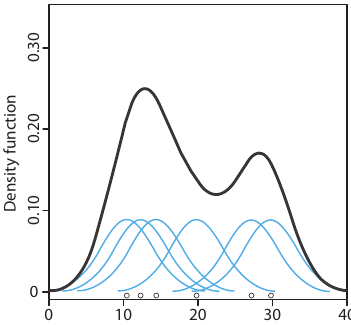
Figure 4. The Gaussian kernel density estimator is a function that stacks a Gaussian “bell curve” on top of each measurement and whose standard deviation, determined by the local probability den- sity, defines the bandwidth (the equivalent to the histogram’s bin